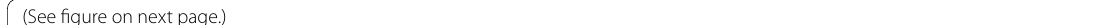
points, 5 m spaced) along the ERT line (for technical rea- To obtain further seismic evidences of the subsurface 2D structure and testing the potentialities of simple pro- sons just slightly shorter). The goal was the computation of the single-component amplitude spectra (for all the cedures based on the spectral analysis of multi-compo- three components) and the HVSR 2D section to compare nent and multi-offset passive seismic data, we recorded with the ERT line. an additional 3-component data set along a 55 m line (12 (See figure on next page.) Fig. 12 Beligna#1 HS (active) data: comparing traces and amplitude spectra for the central (HS1) and western (HS2) sites (same source, stack and offset—see map in Fig. 8a and trace comparison in Fig. 11): a seismic traces and amplitude spectra (arbitrary unit) for HS1; b seismic traces and amplitude spectra for HS2 [vertical scale adapted to meet the actual data amplitudes for each site]; c comparison of the amplitude spectra of the R and T components while using the same vertical scale so to allow a clearer comparison of the data amplitudes for the central (HS1) and western (HS2) data. Due to the larger attenuation, the amplitude of the HS2 traces is considerably lower and the peak value migrates toward lower frequencies (high frequencies suffer from higher